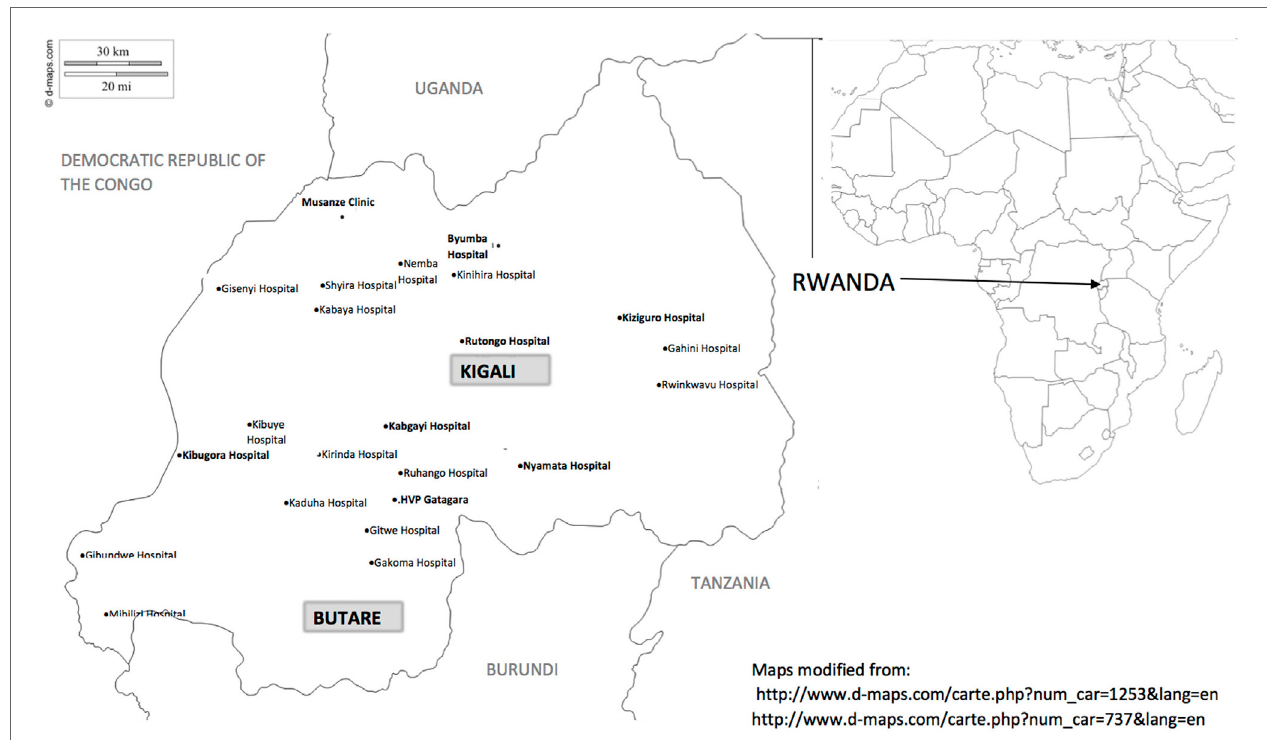
Figure 1 | Clinics and hospitals with PTs participating in the Leadership Institute. (Hospitals in Kigali and Butare are not